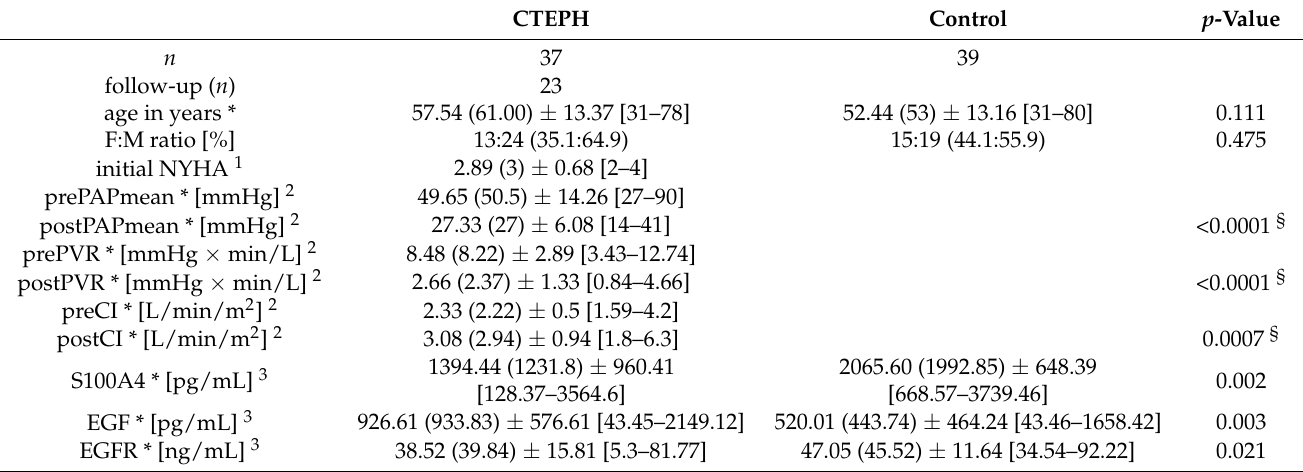
Table 1. Basic demographic and hemodynamic data of CTEPH patients. Concentrations of EndMT biomarkers in CTEPH patients and healthy controls are reported. Controls were age- and sex-matched.